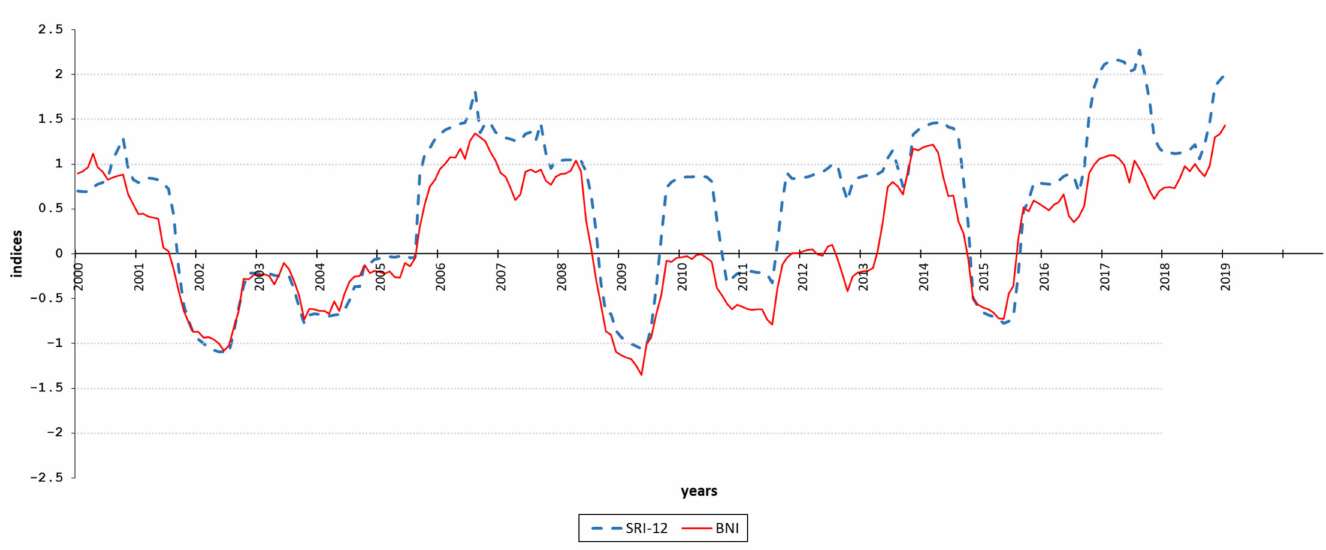
Figure 17. Annual BNI for time series from 1966 to 2019.